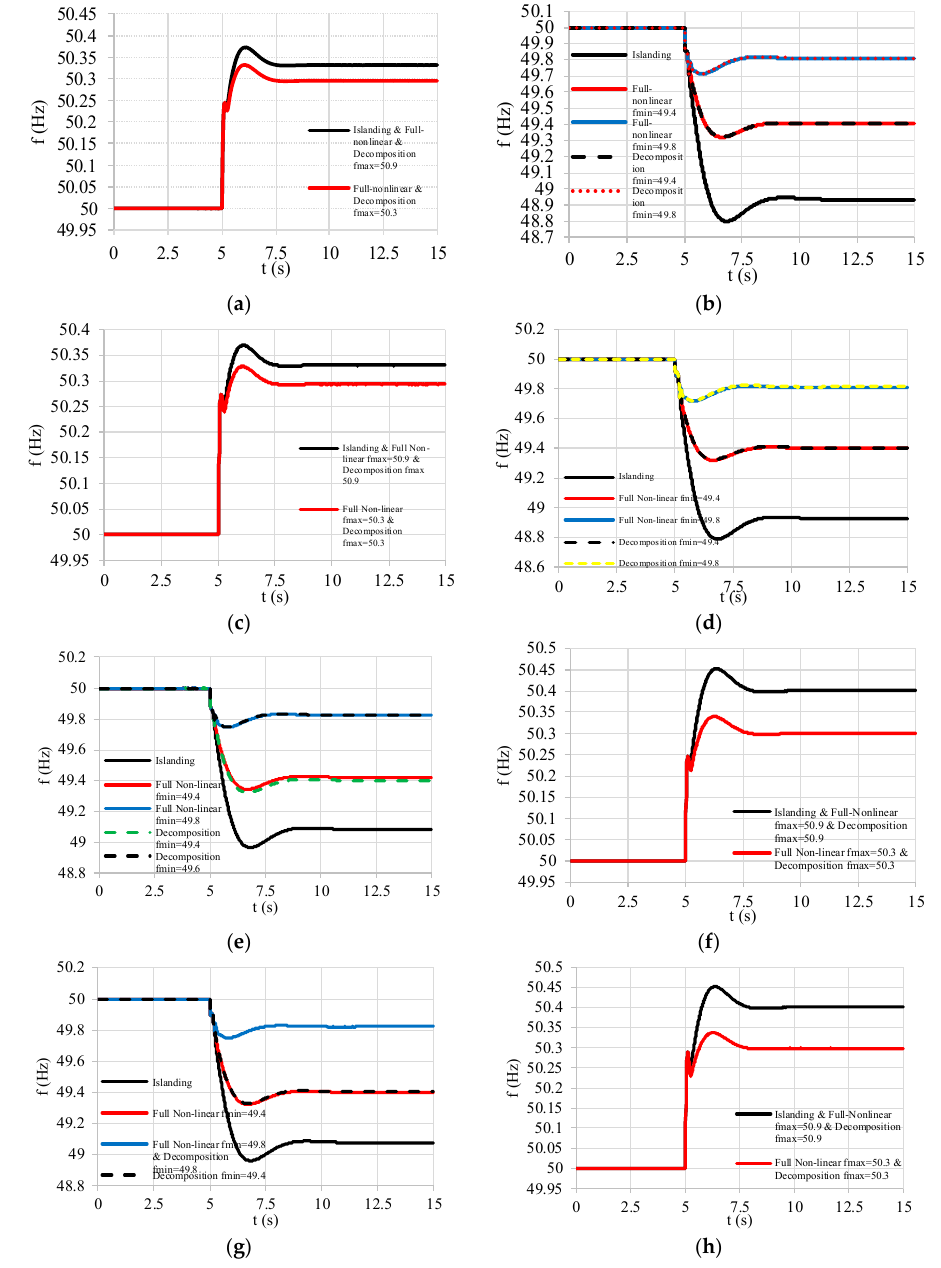
Figure 13. Dynamic frequency response of the network for the cases of the high generation penetration configuration: ( a ) Case 4: DN1; ( b ) Case 4: DN2; ( c ) Case 5: DN1; ( d ) Case 5: DN2; ( e ) Case 6: DN1; ( f ) Case 6: DN2; ( g ) Case 7: DN1; ( h ) Case 7: DN2.